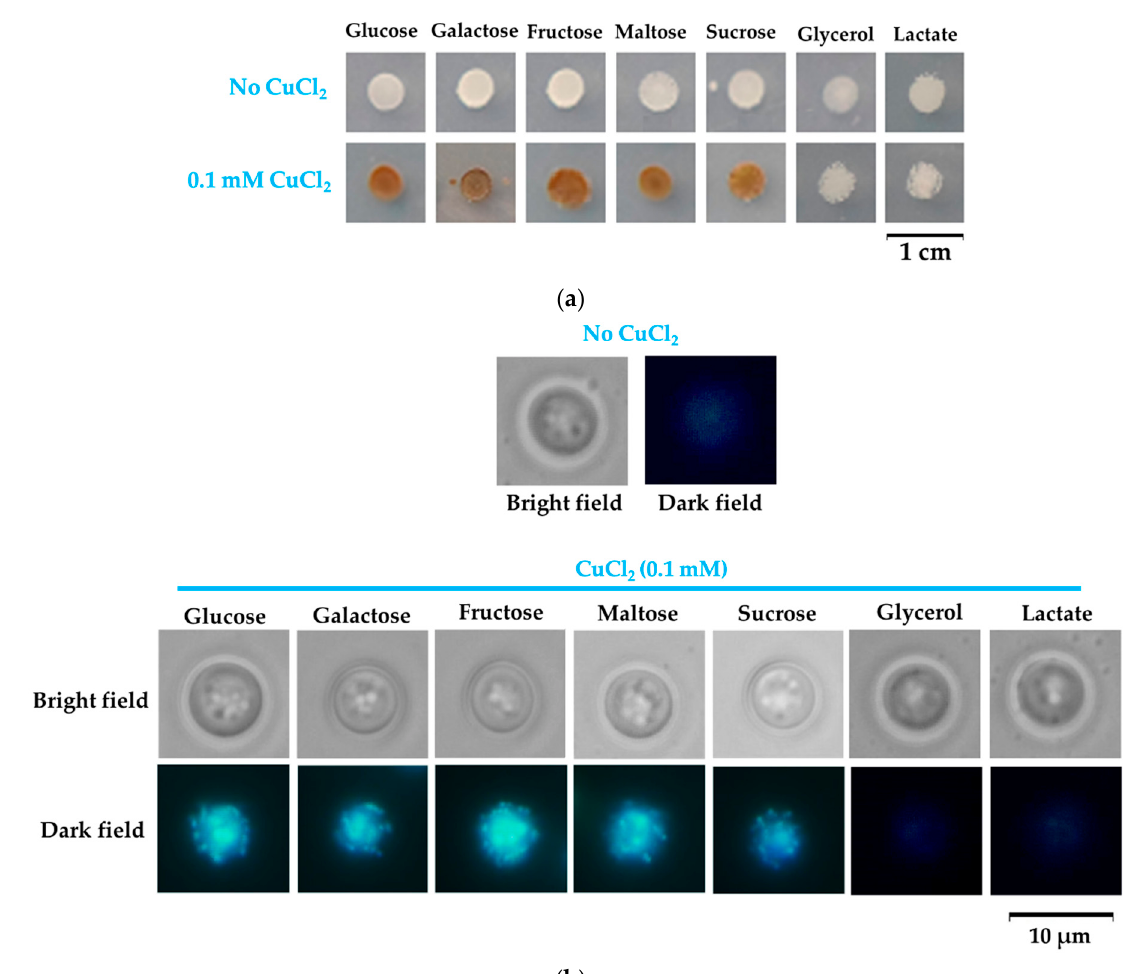
Figure 8. Influence of carbon source on copper deposition on the Saccharomyces cerevisiae cells. ( a ) Cell suspensions of strain BY4741 were spotted (5 µL containing approximately 10 4 cells initially) onto MM/Glc (Glucose), MM/Gal (Galactose), MM/Fru (Fructose), MM/Mal (Maltose), MM/Suc (Sucrose), MM/Gly (Glycerol), or MM/Lac (Lactate) media with or without 0.1 mM CuCl 2 . Plates were photographed after 6 days of incubation at 28 °C. ( b ) Microscopic images of yeast cells isolated from cell population shown in ( a ). Cells were picked by a sterile loop, washed gently, and suspended in 5 µL water directly in the microscope slide. For bright-field images, automatic time exposure was used (an average of 1 ms). For dark-field images, exposure time was 1 s.